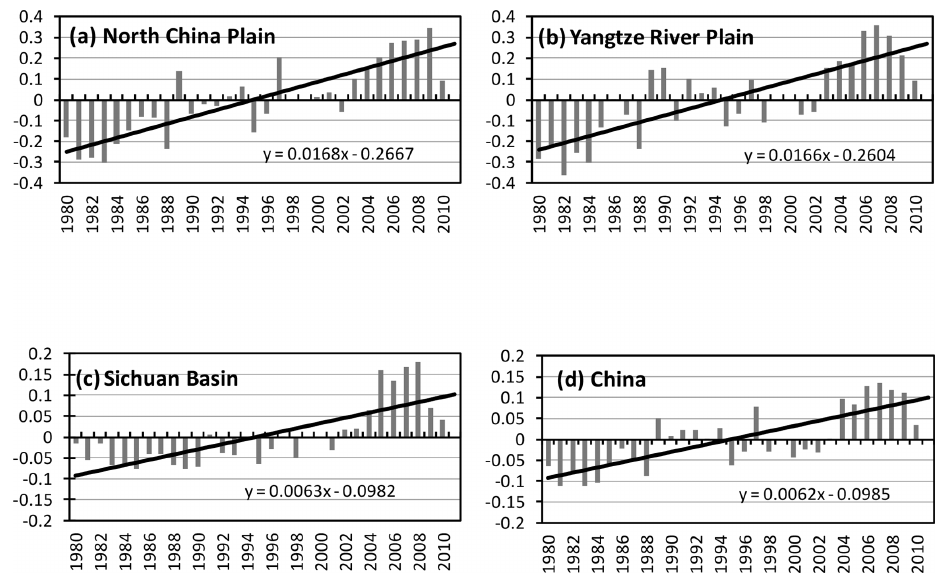
Figure 2. Anomalies and trends of the ratio of visibility in the North China Plain, Yangtze River Plain, Sichuan Basin and China as a whole. The relative contribution of hygroscopic aerosols to the visibility reduction has increased from 1980 to 2010 in China.